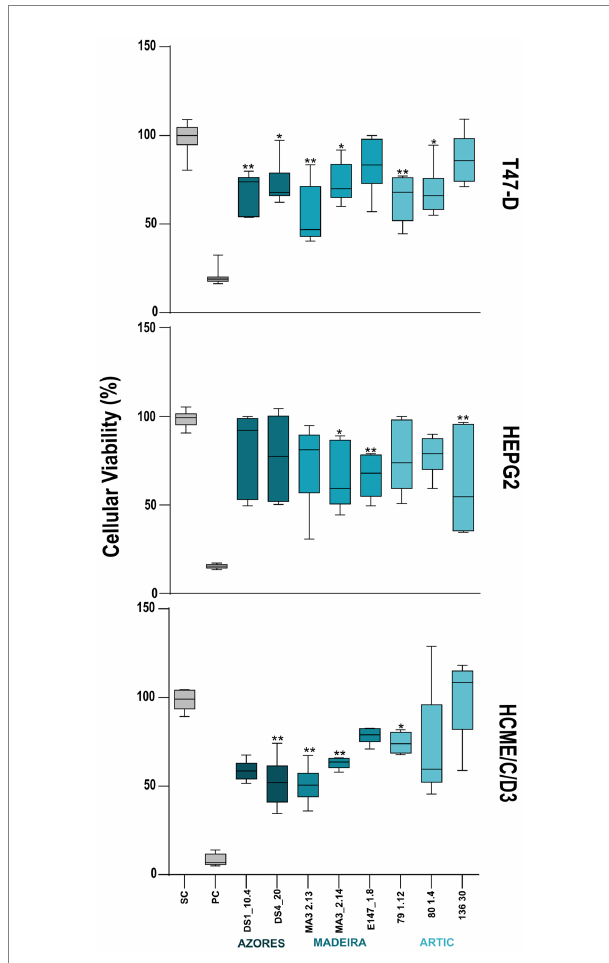
FIGURE 4 Cytotoxic activity of the deep-sea actinobacterial crude extracts tested at 15 μ g/ml. The effects on the viability in the two cancer cell lines: breast ductal carcinoma (T-47D) and liver hepatocellular carcinoma (HepG2), as well as in the non-cancer cell line hCMEC/D3 (human brain capillary endothelial cells) are shown after 48 h of exposure. Only the extracts with statistically significant differences are indicated on the graphs. PC and SC mean positive and solvent controls, respectively. Values are represented as interval displaying the data distribution through their quartiles with 5–95% confidence from two independent assays conducted in triplicate and line within the box-whisker represents the median. Significant differences compared to the solvent control are annotated with asterisks in the graphs (* p < 0.05; ** p < 0.01; *** p < 0.001; **** p <